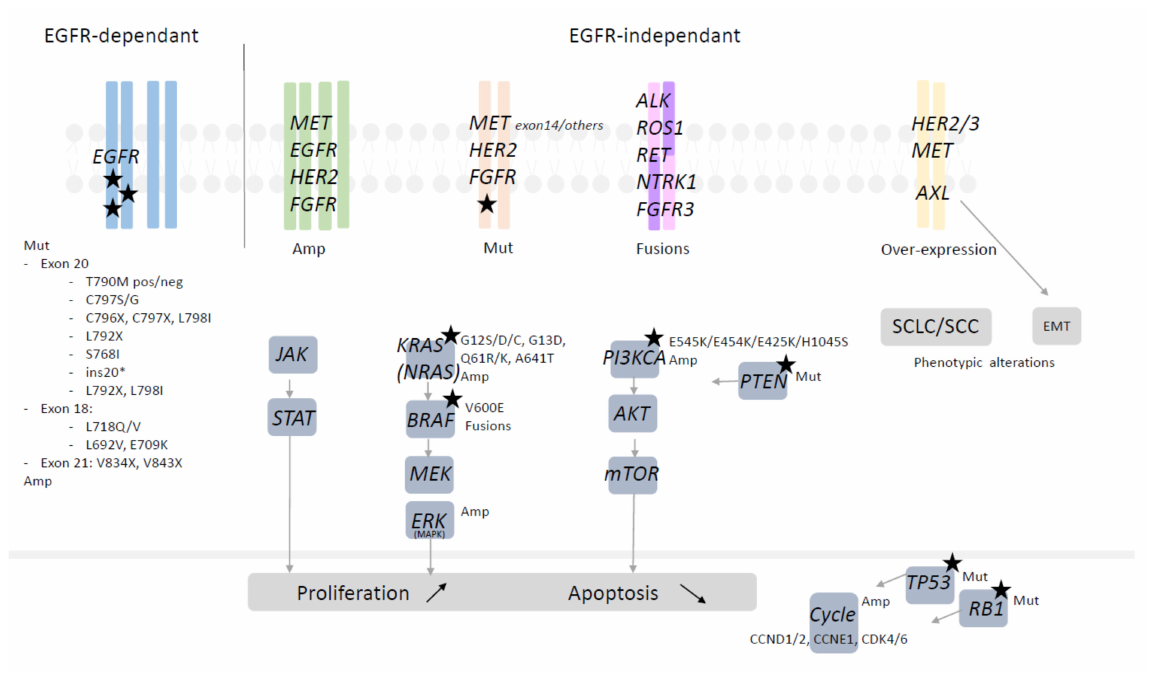
Figure 3. EGFR signaling pathway and EGFR-TKIs’ acquired resistance